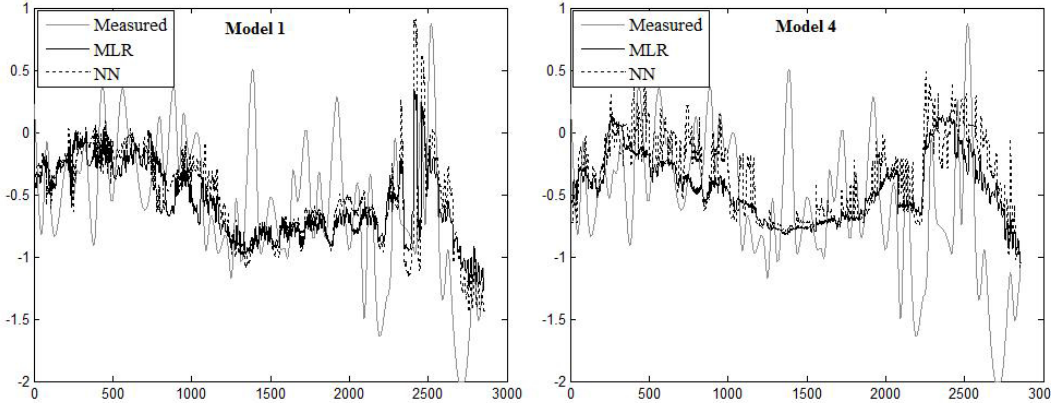
Figure 3. The testing periods of Model 1 (left) and the testing periods of Model 4 (right).